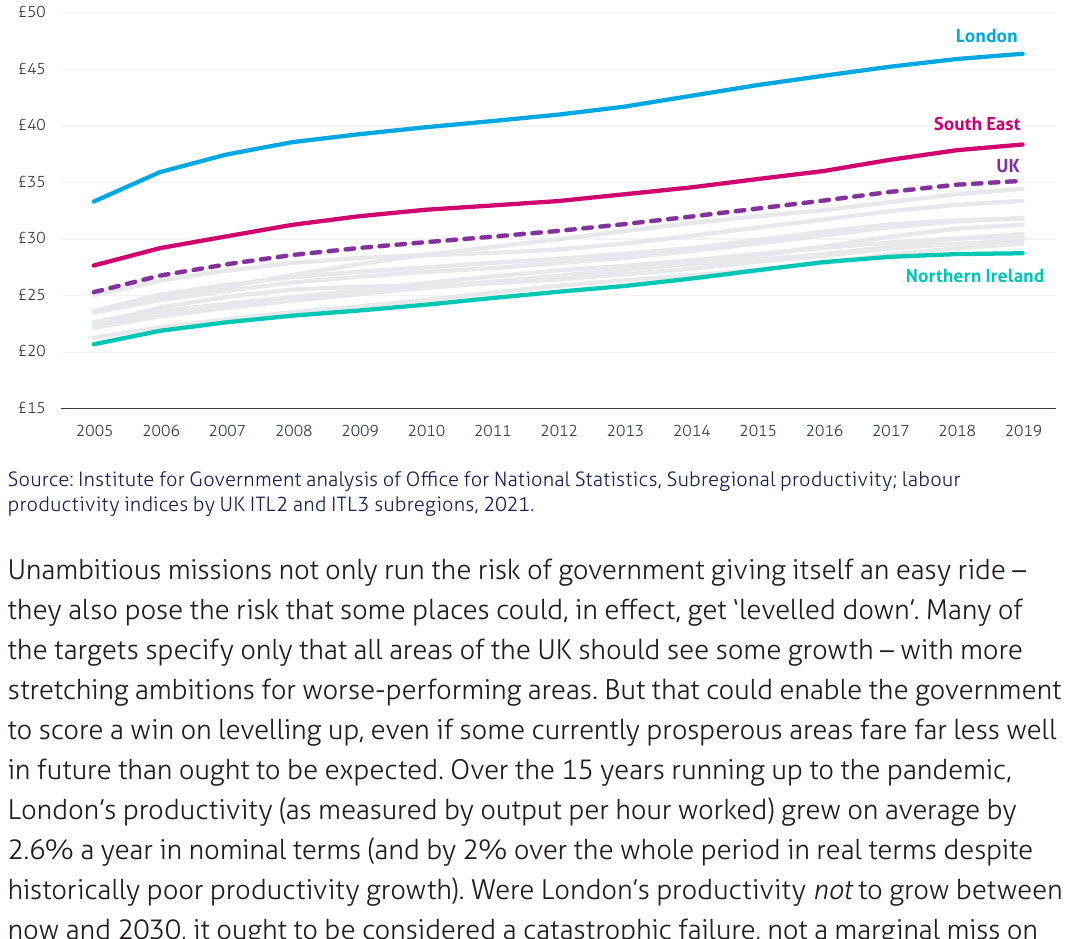
Figure 2 Nominal (smoothed) GVA per hour worked